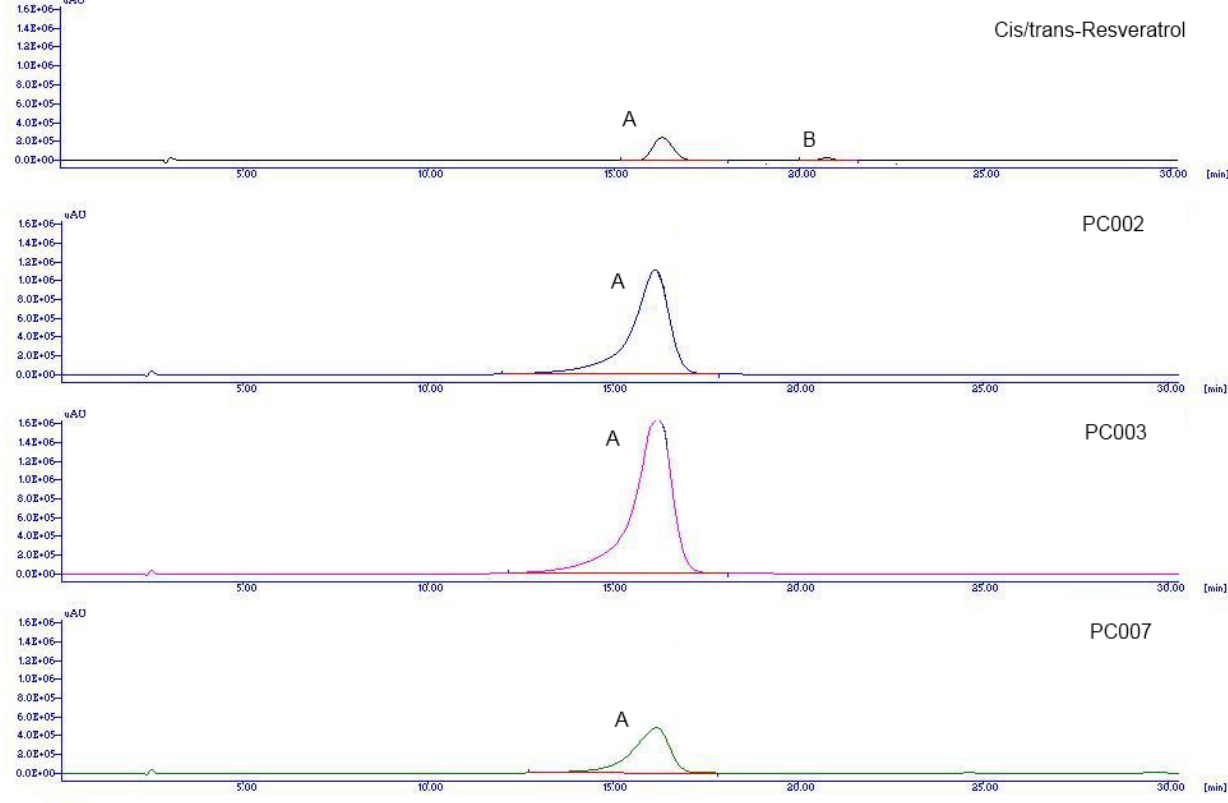
Figure 4. HPLC chromatograms of cis/trans -resveratrol, PC002, PC003 and PC007.